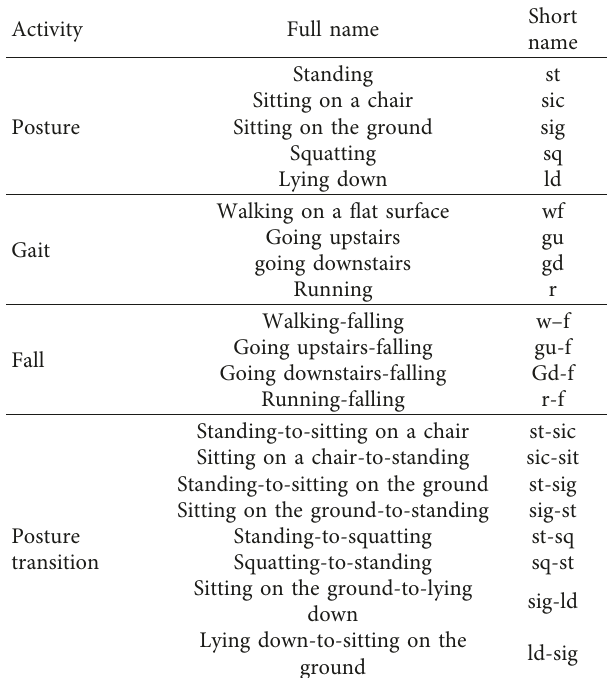
Table 1: Identification